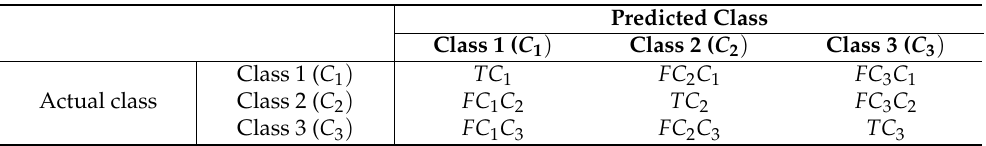
Table 2. Three-class confusion